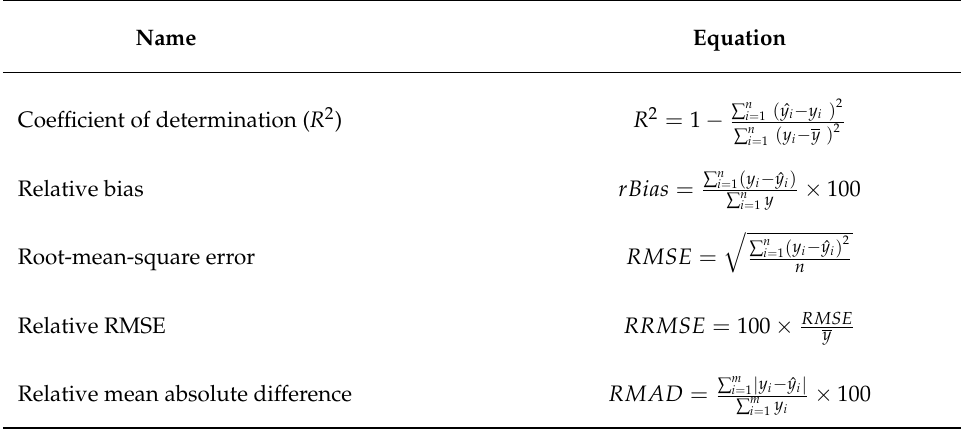
Table 4. Performance metrics applied for this study, where y i is the observed variables, y is the mean of the observed variables, ˆ y i is the estimated variables, n is the number of bands, and m is the number of